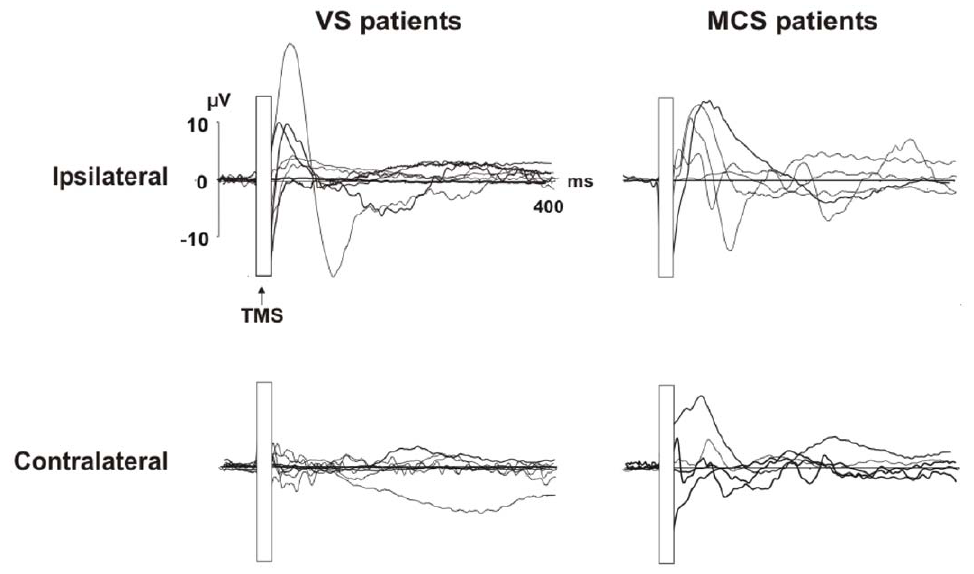
Figure 2. Individual TEPs recorded from both hemispheres for the two groups of patients: VS patients are shown in the left column, and MCS patients are shown in the right column. TEPs recorded over the stimulated hemisphere are displayed in the upper row, and TEPs recorded over the contralateral hemisphere are in the lower row.